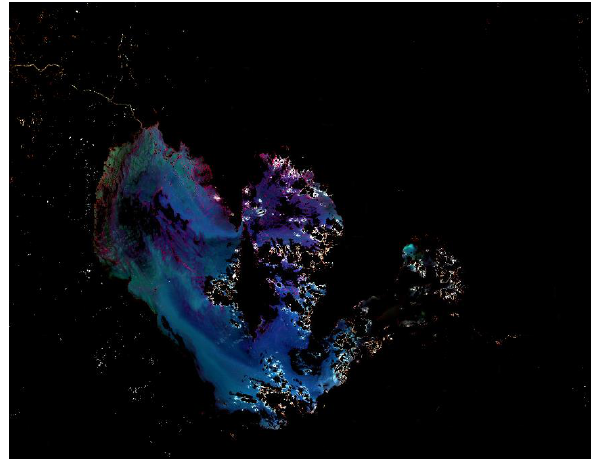
Figure 4. Laguna Lake cloud and land masked